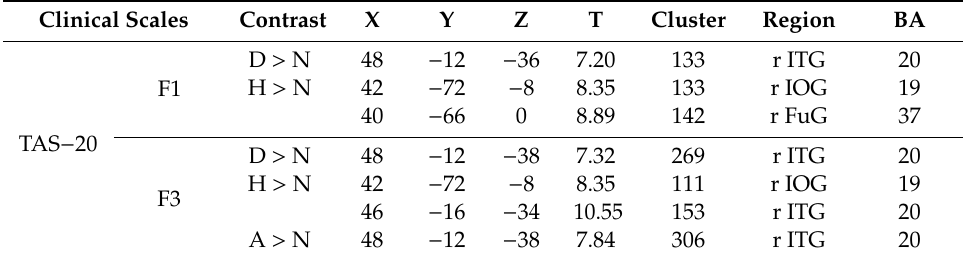
Table 3. Brain regions whose activity was positively correlated to TAS-20 scores in fathers, when contrasting infant emotional faces to infant neutral